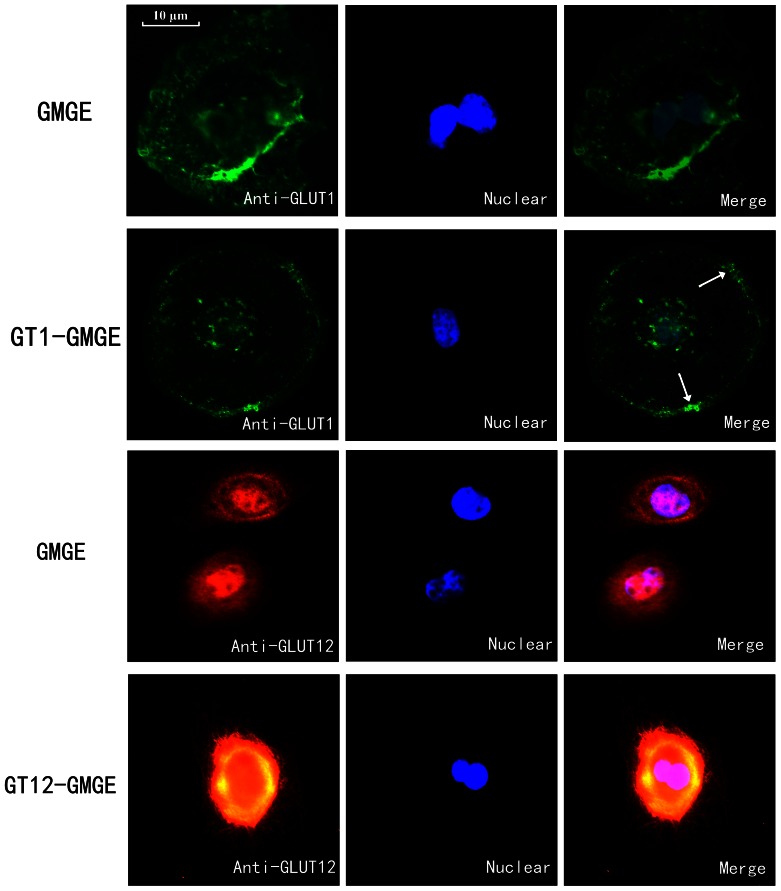
Immunofluorescence localization of goat GLUT1 and GLUT12 in GT1-GMGE and GT12-GMGE.Cells were fixed with paraformaldehyde, permeablized and incubated with antibody of GLUT1 or GLUT12. At last, the plate incubated with DAPI. The green fluorescence was scattered throughout the cytoplasm in GMGE. In GT1-GMGE cells, the total GLUT1 was mainly distributed along the plasma membrane in addition to the cytoplasm. The red fluorescence was mainly distributed around the nuclear in GMGE, while the GLUT12 expression was increased and was also mainly distributed in the perinuclear region in GT12-GMGE cells. Original magnification 400×.